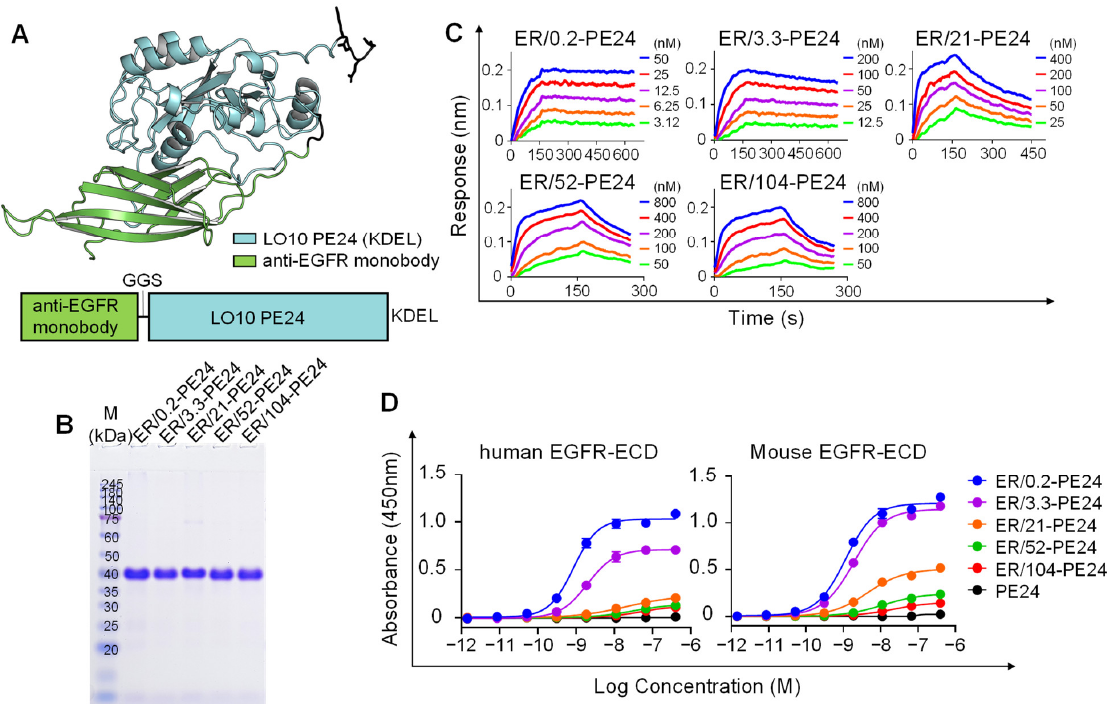
Figure 1. Generation and characterization of ER-PE24 IT variants with different affinities for EGFR. ( A ) Schematic view of the ER-PE24 IT construction (lower panel), and predicted structure via AlphaFold (AlphaFold v.2.0) (upper panel). The anti-EGFR monobody (Green) was fused to the N-terminus of the B-cell epitope-removed PE24 toxin, LO10 PE24 (Cyan), via a GGS linker. ( B ) SDS-PAGE analyses of the purified ER-PE24 ITs (each 5 μg loading) under non-reducing conditions. The gel was stained with Coomassie Blue R-250. ( C ) Representative binding isotherms of the immobilized EGFR-ECD-Fc in relation to soluble ER-PE24 IT, as measured by bio-layer interferometry. The concentrations of ER-PE24 IT analyzed are indicated using different colors. The binding kinetics parameters are listed in Table 1. ( D ) Concentration-dependent binding activities of ER-PE24 ITs to human or murine EGFR-ECD, as determined by ELISA. Error bars represent the mean ± SEM ( n = 3).